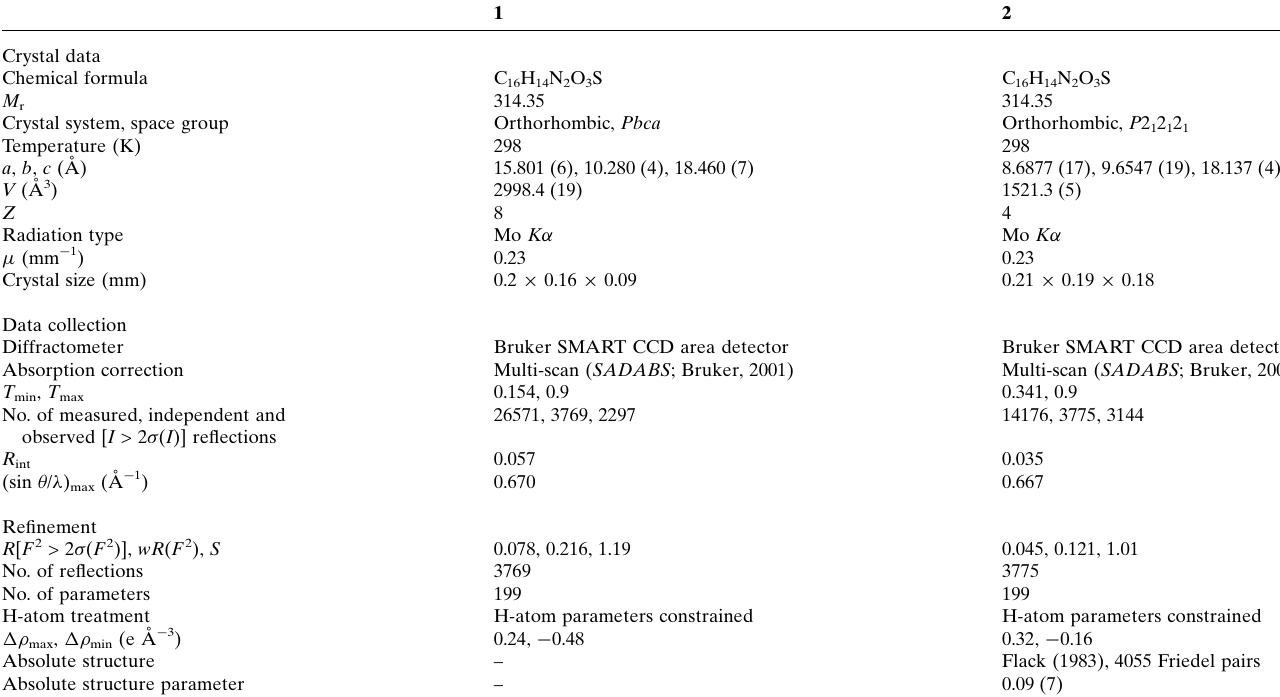
Table 3 Experimental details.